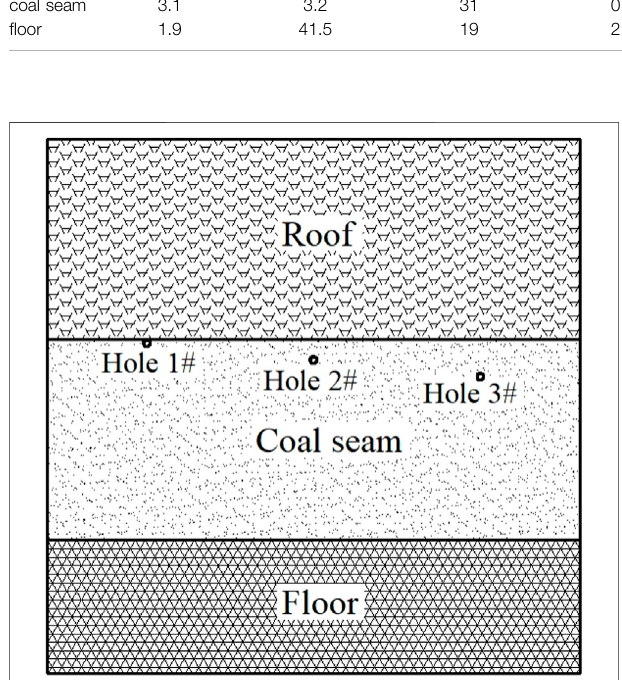
FIGURE 3 | Schematic diagram of model borehole